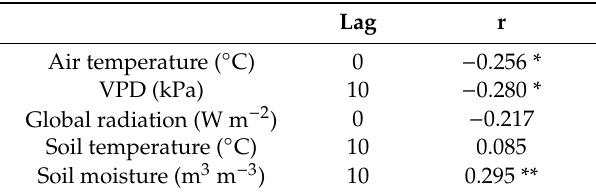
Table 2. Pearson correlation coe ffi cients for the δ 13 C eco with environmental factors in the growing season. δ 13 C eco and daily average meteorological data were used to conduct this analysis. The lag time in days and the Pearson’s correlation coe ffi cient (r) are presented, and only the correlation that provided the best r value is